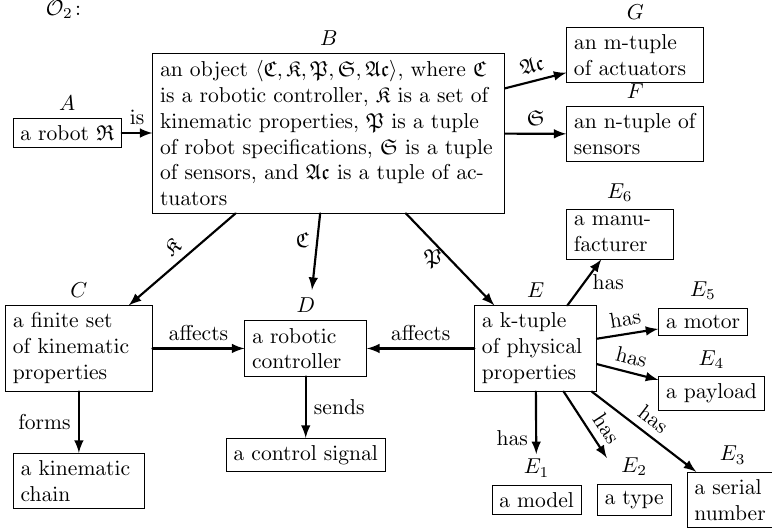
Figure 5. Olog representation of a robot based on Definition